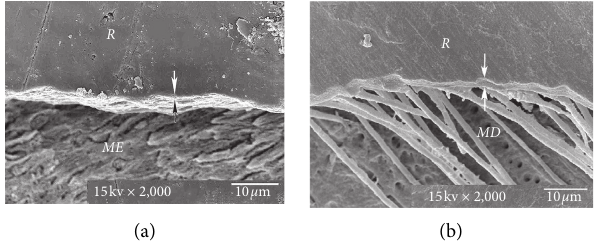
Figure 4: SEM micrograph of Super-Bond D-liner II Plus restored amalgam after chemical challenge, demonstrating the consistent and continuous thickness of the hybrid layer ( ≈ 3-4 μ m, arrowed) in the enamel (a) and dentin (b) (original × 2,000, ME � modified enamel, MD � modified dentin, and R � resin).